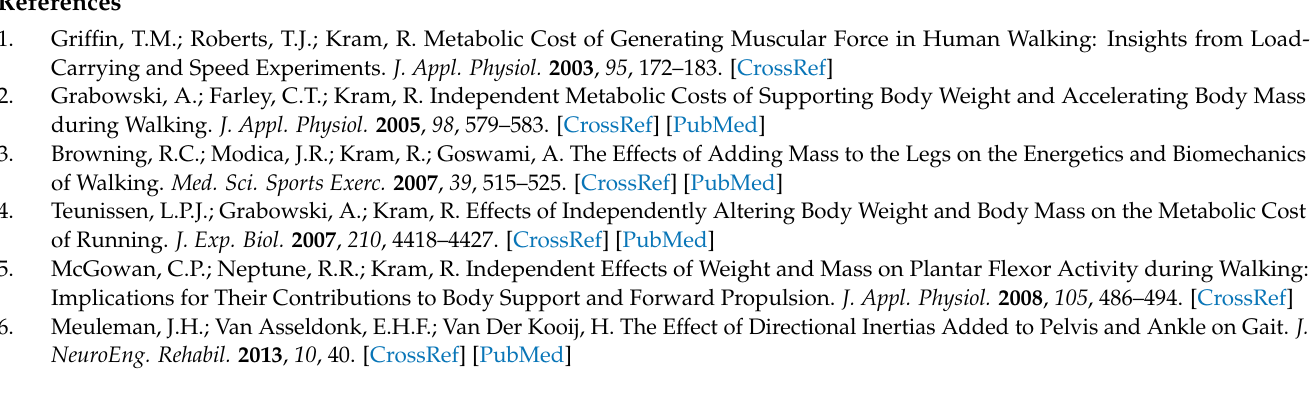
motion capture; Table S3: Highest Pearson Correlation coefficients; Table S4: Mean and Standard Deviation values of sagittal-plane range of motion (RoM) in degrees; Table S5: Mean and Standard Deviation values of the spatiotemporal metrics; Table S6: p -Value (Power) for analyzed metrics with two-way, repeated measures